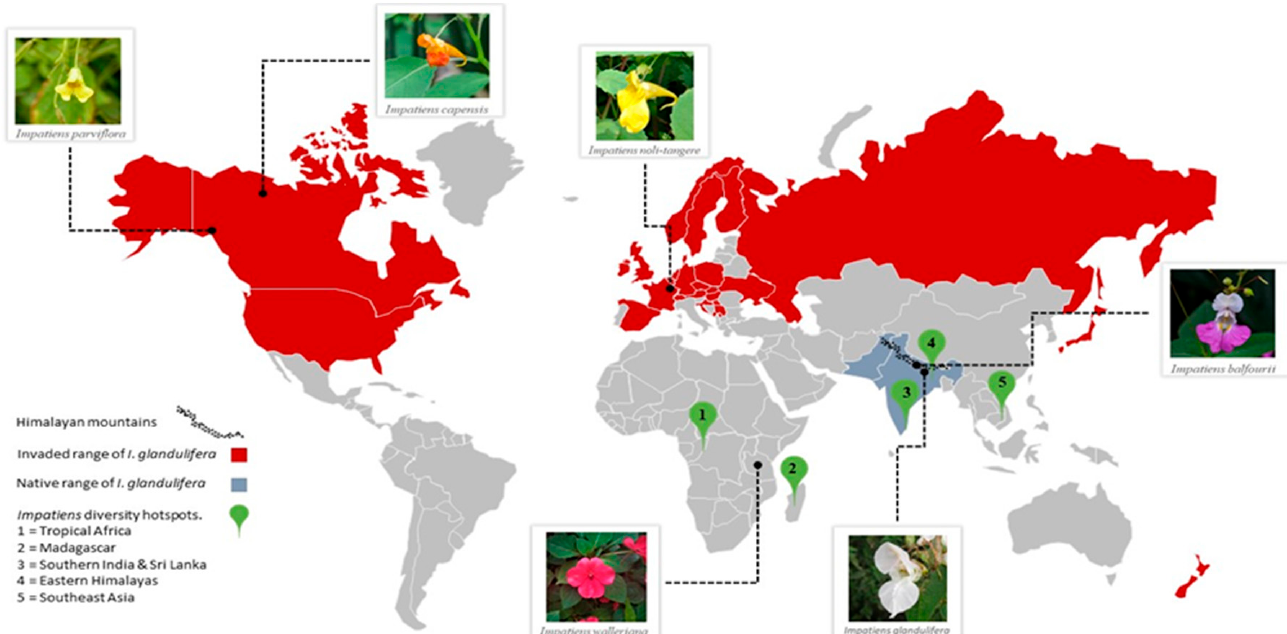
Figure 1. The distribution range of I. glandulifera in its native range (blue) and invaded range (red). The broad distribution of I. glandulifera enables it to be studied in a multitude of different habitats across a broad latitudinal range, highlighting the effect of an invasive across a geographically diverse area. Furthermore, these insights may help develop assisted migration conservation plans. The genus Impatiens is often referred to as ‘poor man’s orchids’ or ‘jewel weeds’- a reference to the high level of phenotypic diversity boosted by the circa 1000 species; among these, there is a high level of endemism, particularly in the five diversity hotspots. Impatiens noli-tangere is the only species native to Europe and is often used in comparison studies [12–15]. Impatiens walleriana and Impatiens parviflora are both considered invasive, with Impatiens capensis , Impatiens balfourii and Impatiens edgeworthii (the latter two found nearby I. glandulifera in the Himalayas) considered potentially invasive [16]. Sources of CreativeCommons images: I. balfourii [17] CC by-SA 4.0, I. capensis [18] CC by-NC-SA 2.0, I. edgeworthii [19] CC by-SA-4.0, I. parviflora [20] CC by 2.0, I. noli-tangere [21] CC by-SA-2.0, I. walleriana [22] CC by-SA 4.0.